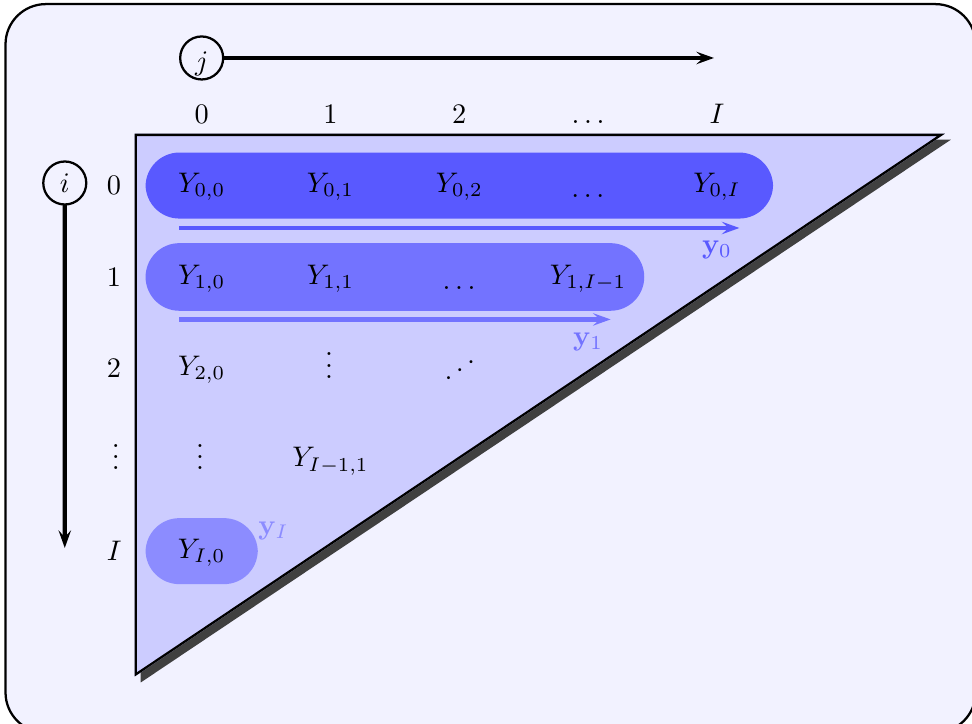
Figure 4. Accident year-based modeling of the observation vector. Taylor et al. (2003) propose a logarithm function as a link function, the noise terms w i are assumed to be gamma-distributed and the ( j + 1 ) -th row of the linear predictor G i x i for an accident year i = 0, . . . , I is given by